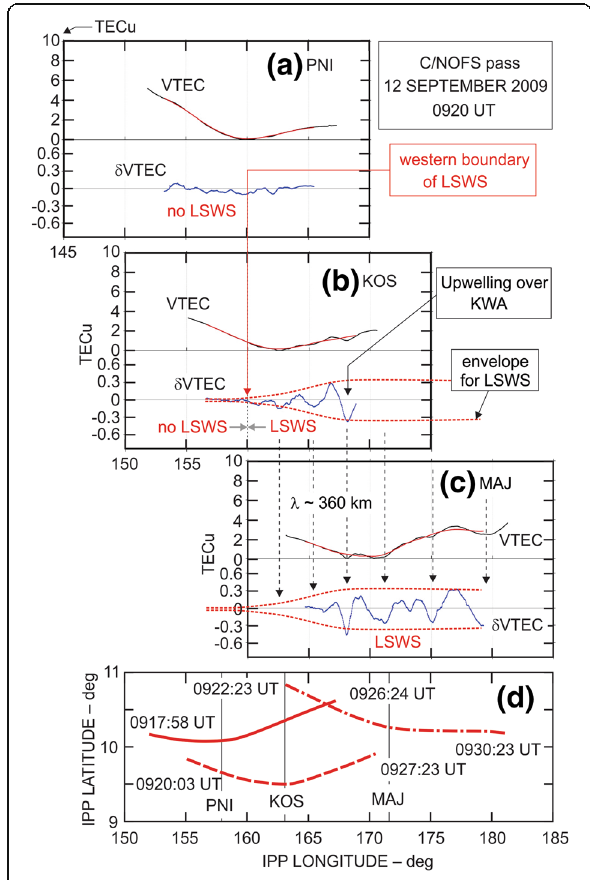
Fig. 8 Vertical TEC and residual TEC versus IPP longitude for a PNI, b KOS, and c MAJ. The black curve is VTEC, red curve is the running average, and the blue curve is the residual difference between these curves. d Tracks of the IPPs frm PNI (solid), KOS (dashed), and MAJ (dash-dot) plotted as a function of latitude and longitude. Figure is a reproduction with some changes in notation from Tsunoda et al. (2010)